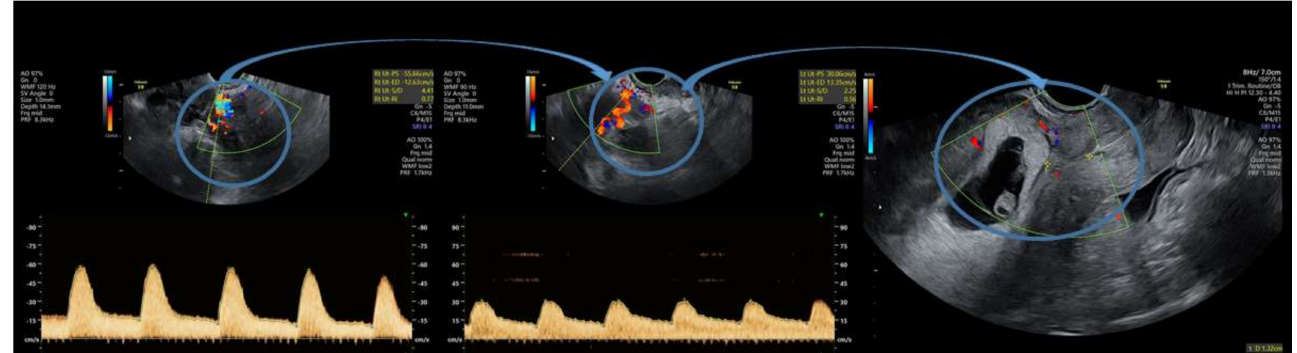
Figure 4. Progression of circulation after successful uterine artery embolization for P6 (shown inside the blue circles, connected via arrows). Complete cession of blood flow occurred after 48 h (artery flow is restored after 24 h since embolization, but then is completely reduced at 48